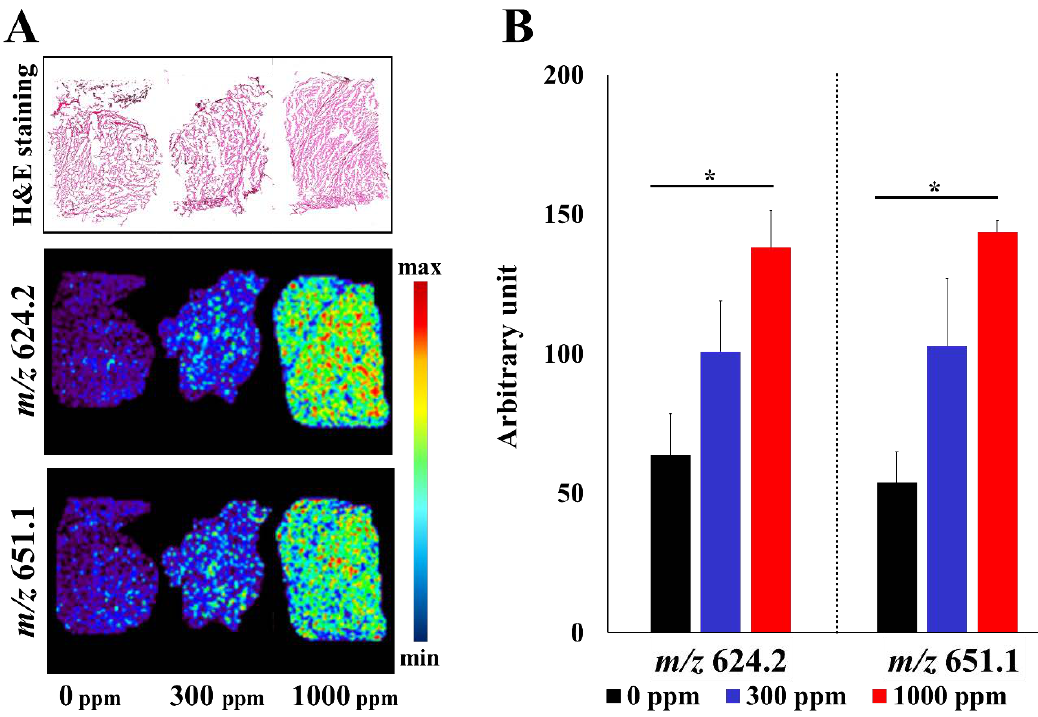
Figure 2. ( A ) MS imaging of three di ff erent fish fillet samples (0, 300, and 1000 ppm FA concentrations). The ion images at m / z 624.2 and m / z 651.1 are shown. ( B ) The results of semiquantitative analyses of ion intensities are also shown ( n = 3). *: Di ff erences with p < 0.05 were considered statistically